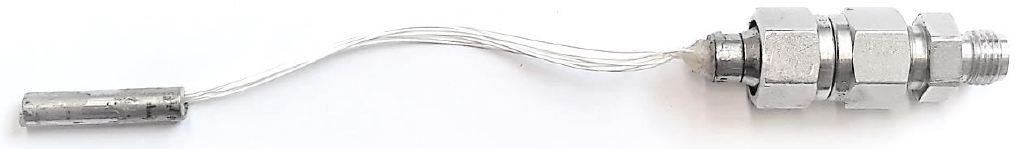
Figure 1. The membrane module containing the polyimide capillaries.